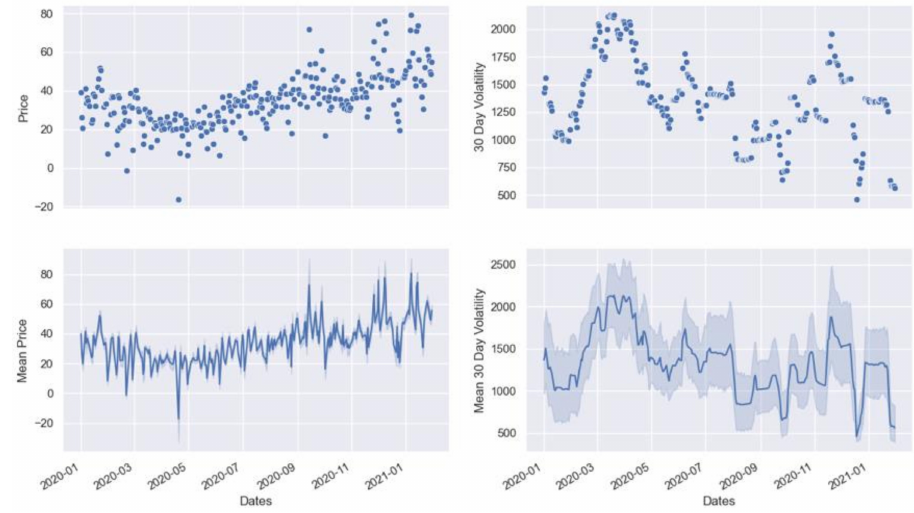
Figure 8. This figure represents the day-ahead price levels for German power including its’ confidence levels on the left side and the 30-day volatility including its confidence levels on the right side. Figures 7 and 8 were generated using the same code in Python.